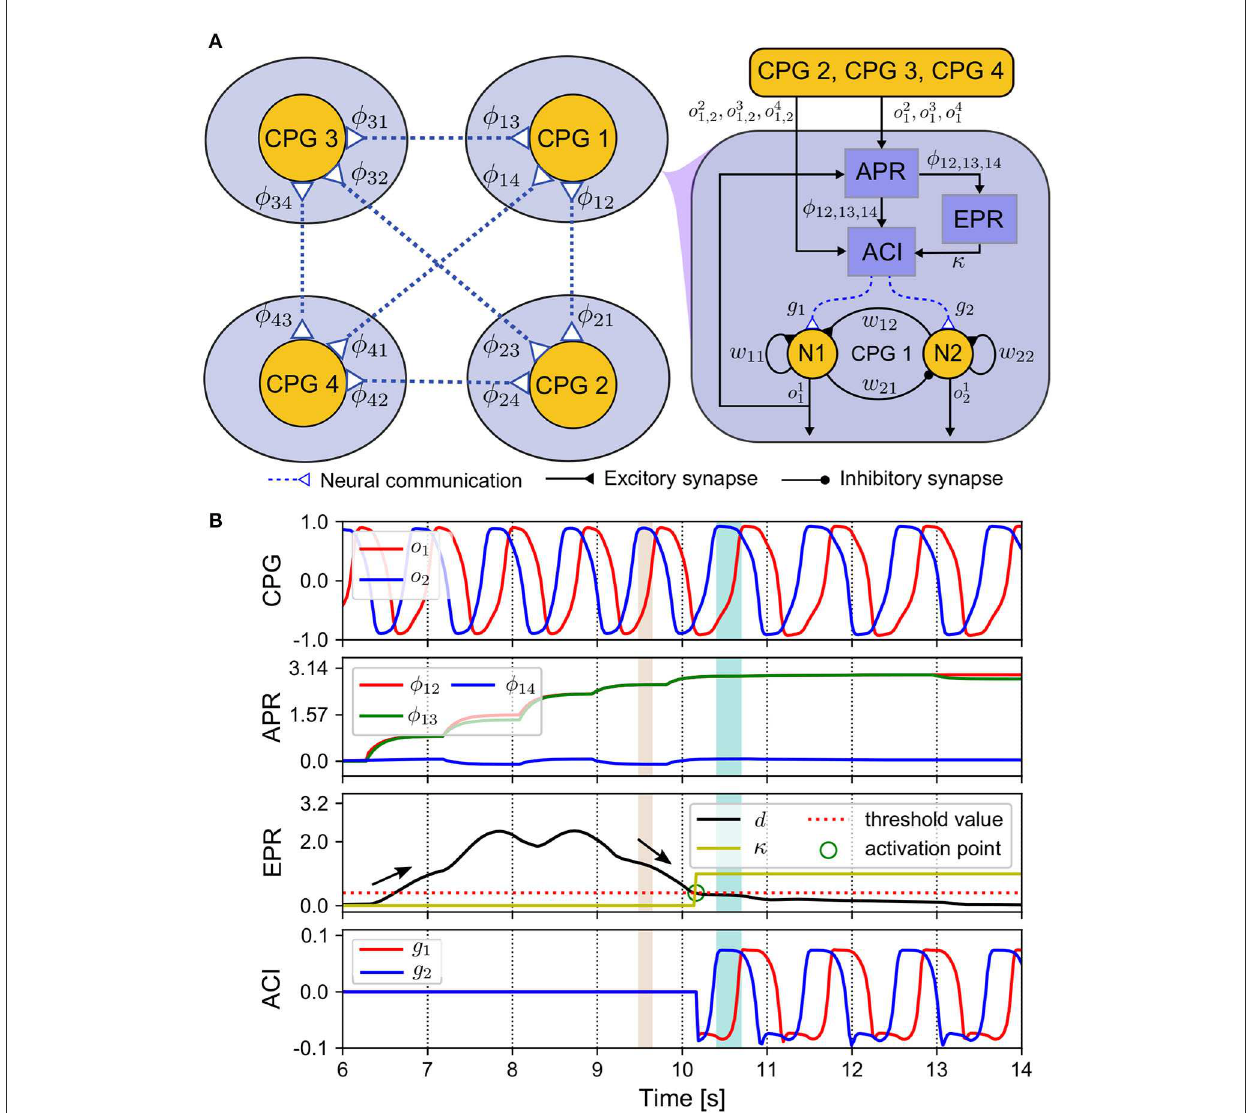
FIGURE3 ANC mechanism. (A) Diagram of the components realizing the ANC. (B) Outputs of these components. The CPG phase relationships ( φ 12 ( n ), φ 13 ( n ), φ 14 ( n )) change from an initial state (0, 0, 0) to a convergence state ( π , π , 0) after 4 s. The control parameters used in this test are listed in Supplementary Table